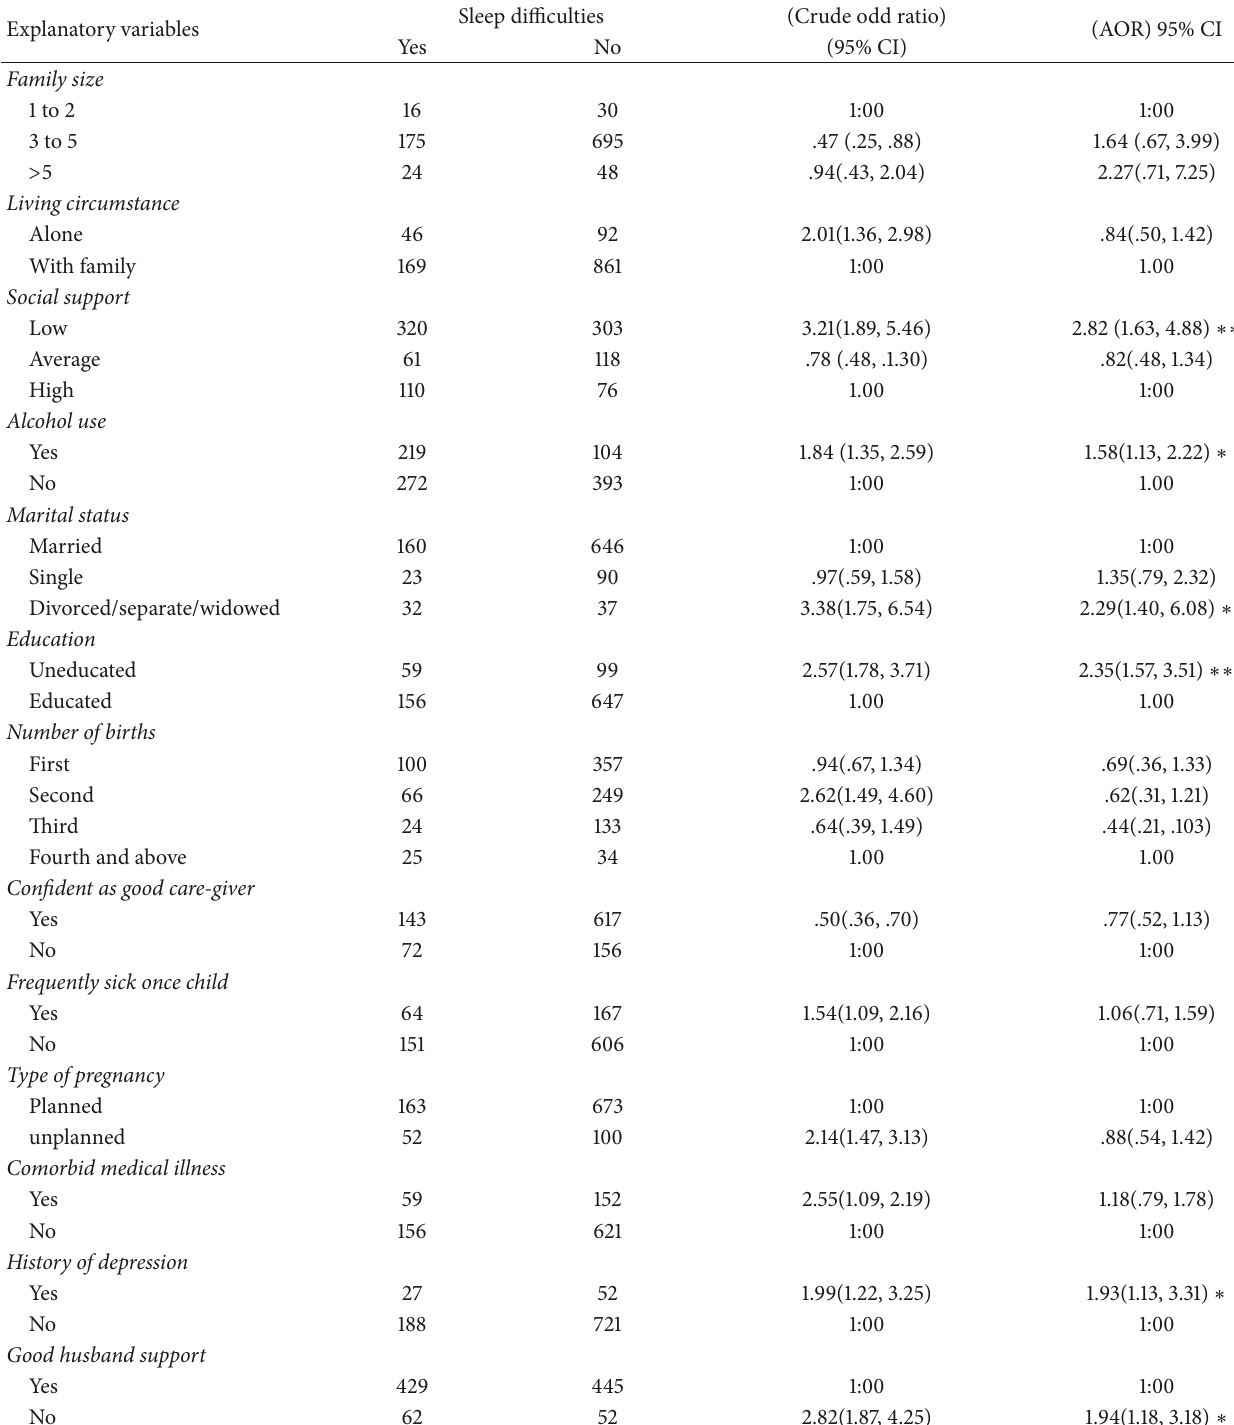
Table 3: Factors associated with insomnia in postpartum